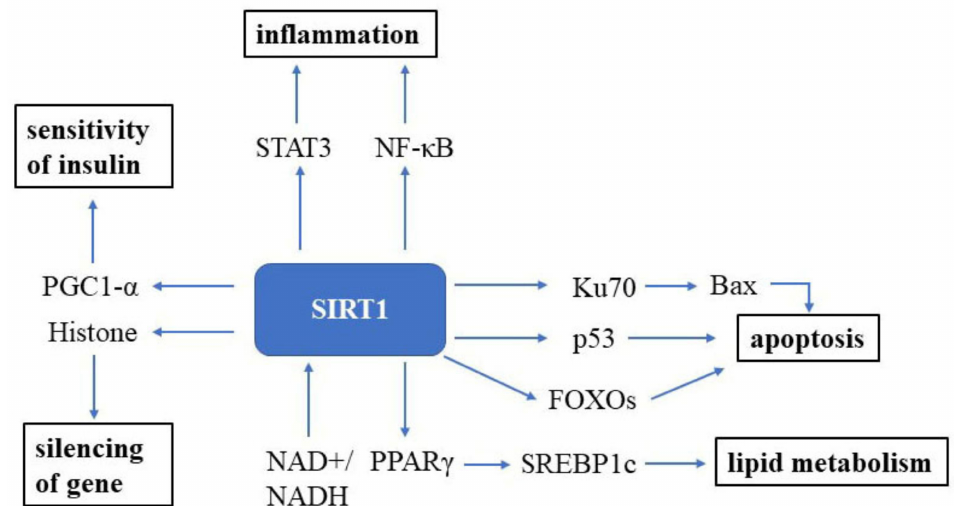
Figure 2. SIRT1 signaling in the cell. SIRT1 is a well-known NAD+-dependent deacetylase that impacts several molecules to promote health. Abbreviations: STAT3: signal transducer and activator of transcription 3; NF- κ B: NF-kappa B; Bax: bcl-2-associated X protein; FOXOs: forkhead box transcription factors; PPAR γ : peroxisome proliferator-activated receptors; NAD+: oxidized nicotine adenine dinucleotide; NADH: reduced nicotine adenine